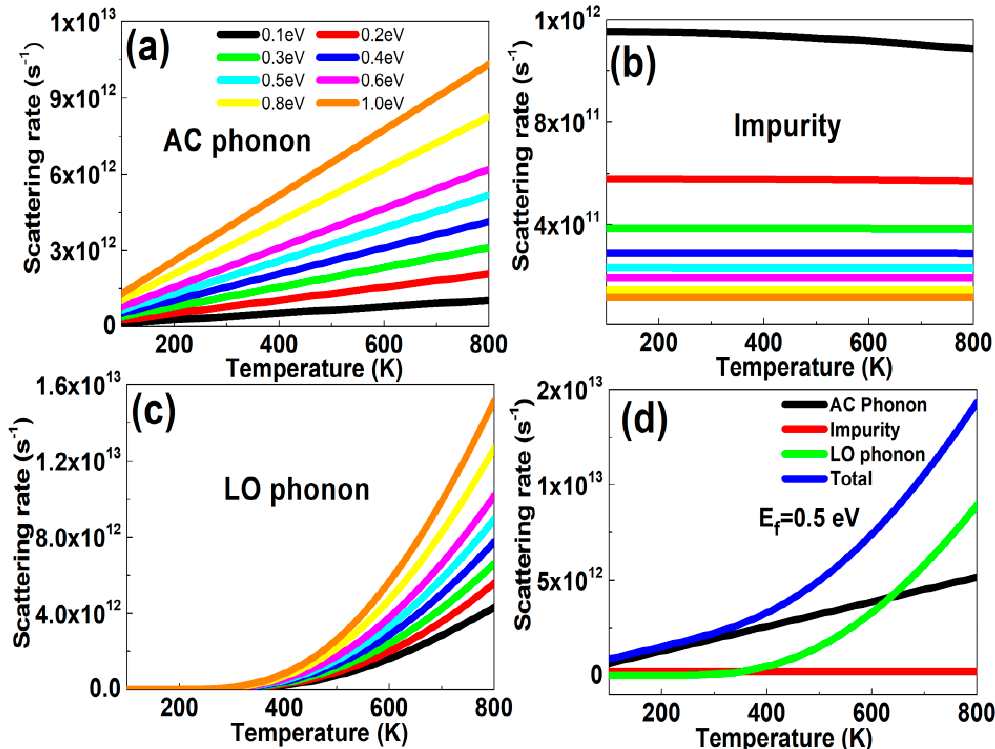
Figure 1. The scattering rates versus temperatures at different Fermi levels. ( a ) Acoustic (AC) phonon scattering, ( b ) impurity scattering, and ( c ) longitudinal optical (LO) phonon scattering. The Fermi levels were 0.1, 0.2, 0.3, 0.4, 0.5, 0.6, 0.8, and 1.0 eV, respectively. ( d ) The influences of several kinds of scattering mechanisms versus temperatures. The Fermi level was 0.5 eV.